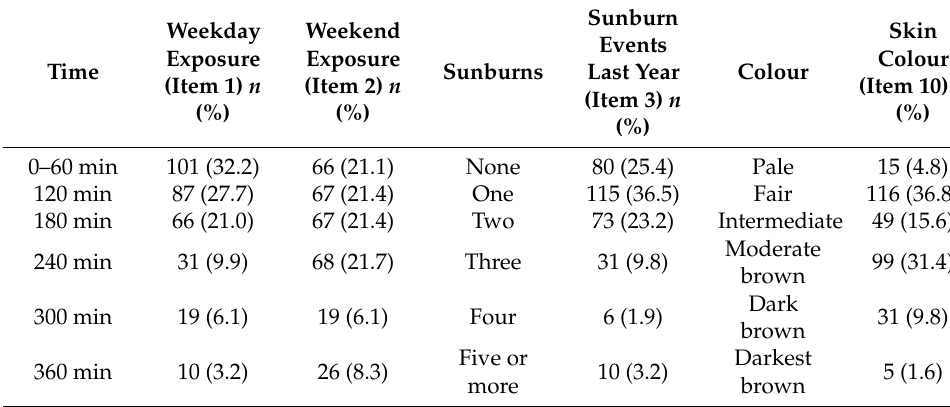
Table 1. Sun exposure practices, sunburn events, and skin